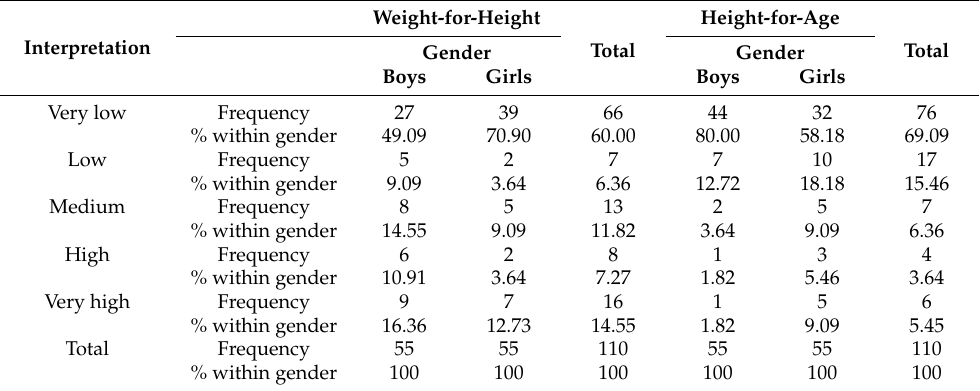
Table 5. Weight-for-age (wasting) and height-for-age (stunting) of the Syrian participants ( n = 110) according to WHO classification system.